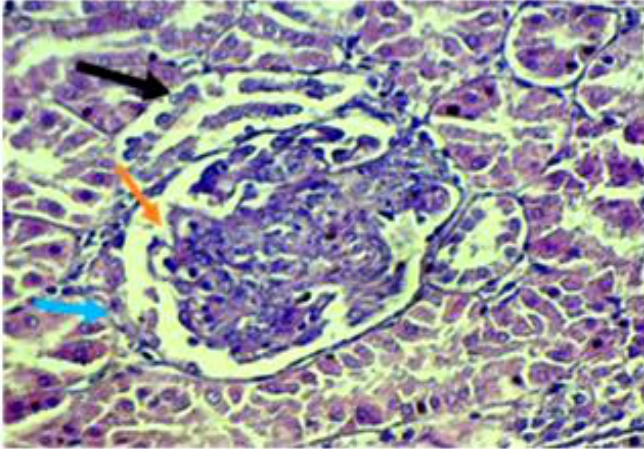
Figure 11. Histopathological section of kidney shows vacuolation in glomerular tuft ( ) and dilation in bowman's space as well as thickening of bowman's capsule ( ) with desquamation of tubular epithelia (